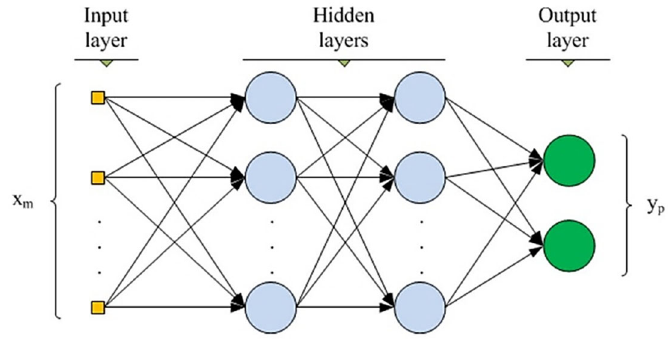
Figure 11. Schematic diagram of a neural network with two hidden layers [29].